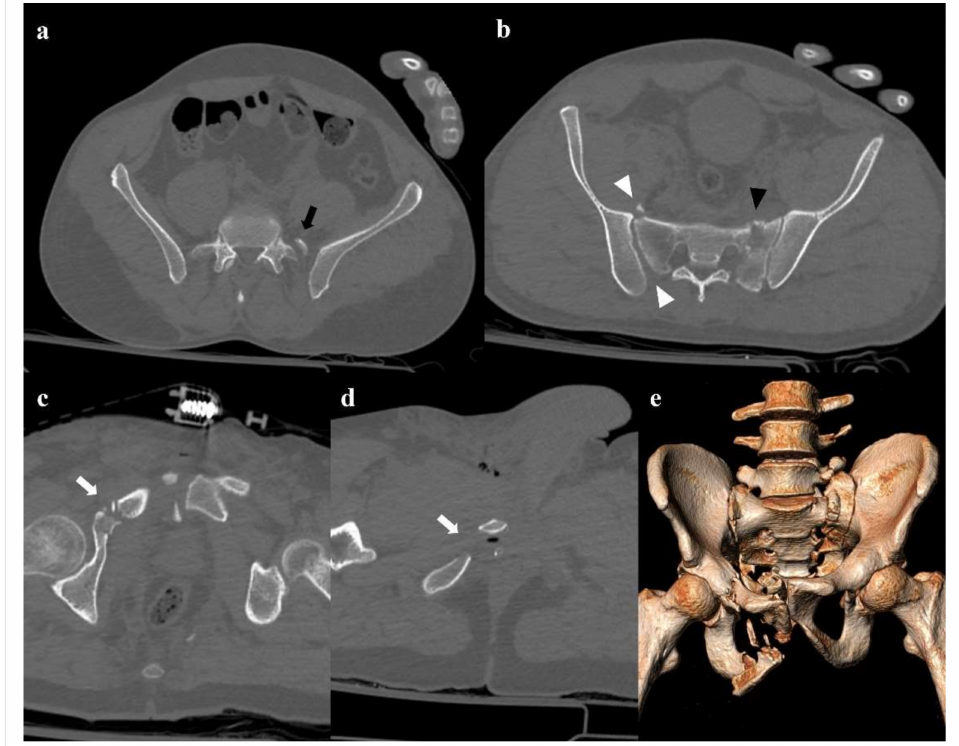
Figure 7. Vertical shear fracture. Axial CT images show avulsion of the left transverse process of the fifth lumbar vertebra (black arrow in ( a )), fracture of the left side of the sacrum with involvement of the foraminal zone (black arrowhead in ( b )), and fracture of the right superior and inferior pubic branches (white arrows in ( c , d )). There is also a little fracture of the right wing of the sacrum, and a posterior widening of the right sacroiliac joint (white arrowheads in ( b )). Three-dimensional volume-rendering CT reconstruction clearly depicts the instability of the pelvic ring, with the fracture of the left transverse process of the fifth lumbar vertebra and the cranial shift of the left hemipelvis ( e